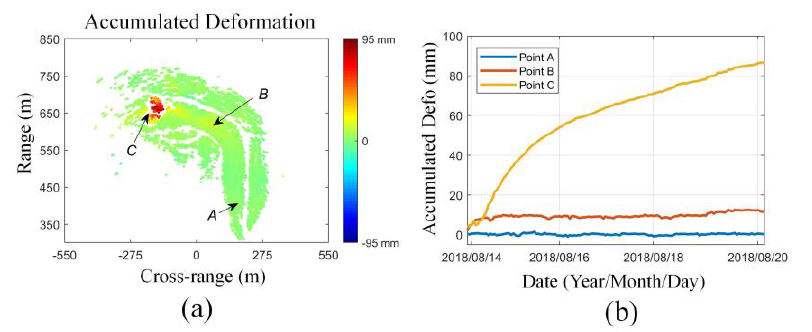
Figure 11. ( a ) The accumulated deformation in the Malanzhaung area. ( b ) The deformation time series of the three points in ( a ). Point A is located in the stable area and its deformation is around zero over the observation duration. Point B shows deformation in a short time (three hours) and becomes stable. The deformation is 11 mm. Point C is located in the deformation center, which moves continuously during the observation period with the accumulated deformation of 85 mm.